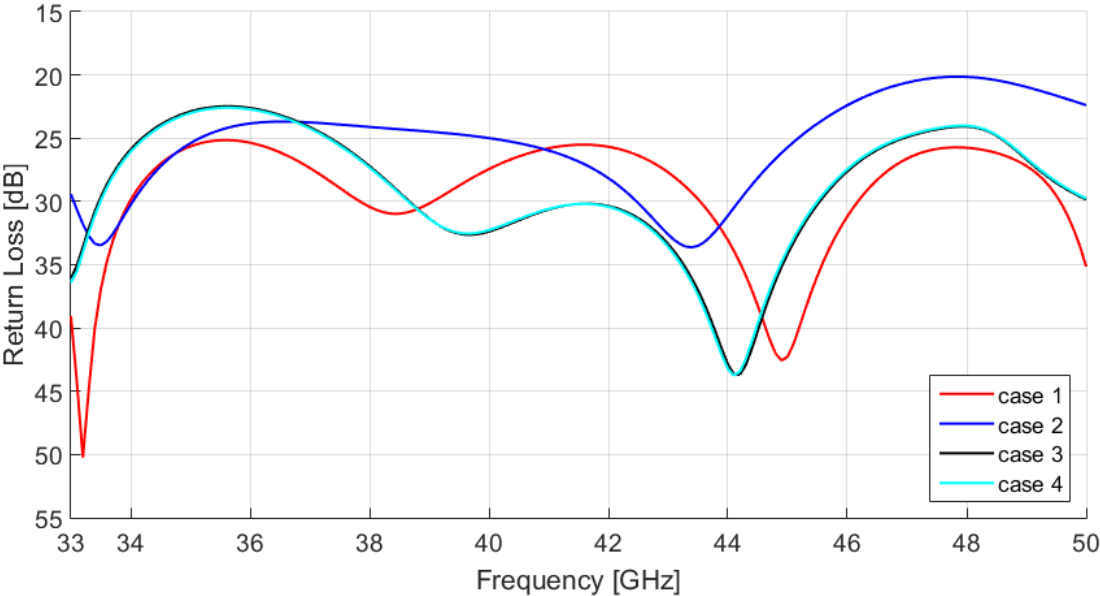
Figure 14. Return loss comparison between the tests on the groove and pin incorrect centering.